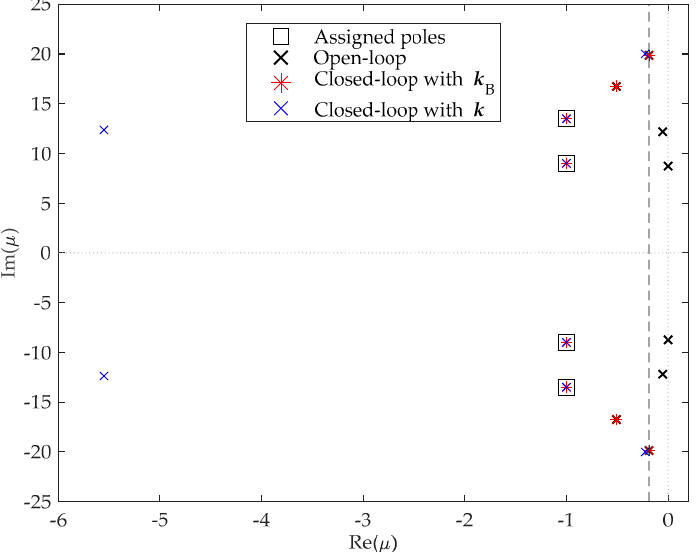
Figure 4. Open-loop and closed-loop poles of the slider-belt system (test-case 2).